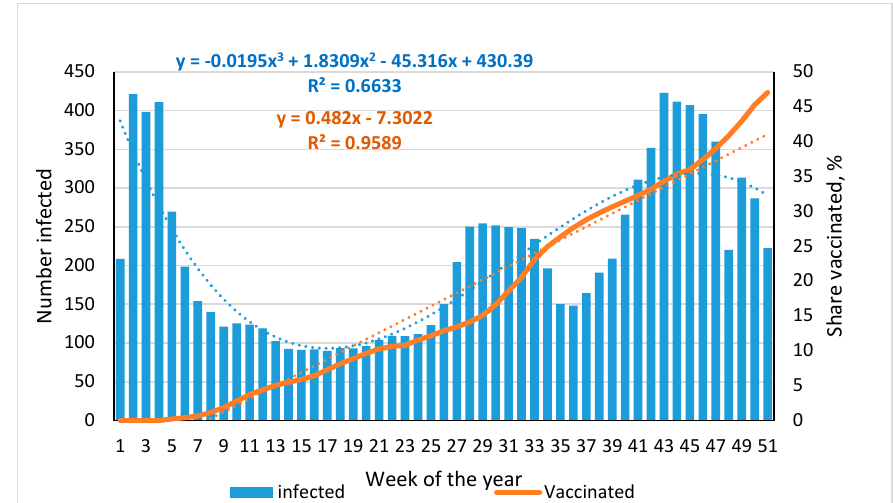
Figure 1. Dynamics of SARS-CoV-2 infection and vaccination of the St. Petersburg population in 2021. The blue dotted line is the infection trend; the regression equation and the coefficient of determination are highlighted in blue and placed at the top center. The brown dotted line is the vaccination trend; the regression equation and the coefficient of determination are highlighted in brown and placed at the top center. The main vaccine used in the Russian Federation was GamCOVIDVac (Sputnik V).